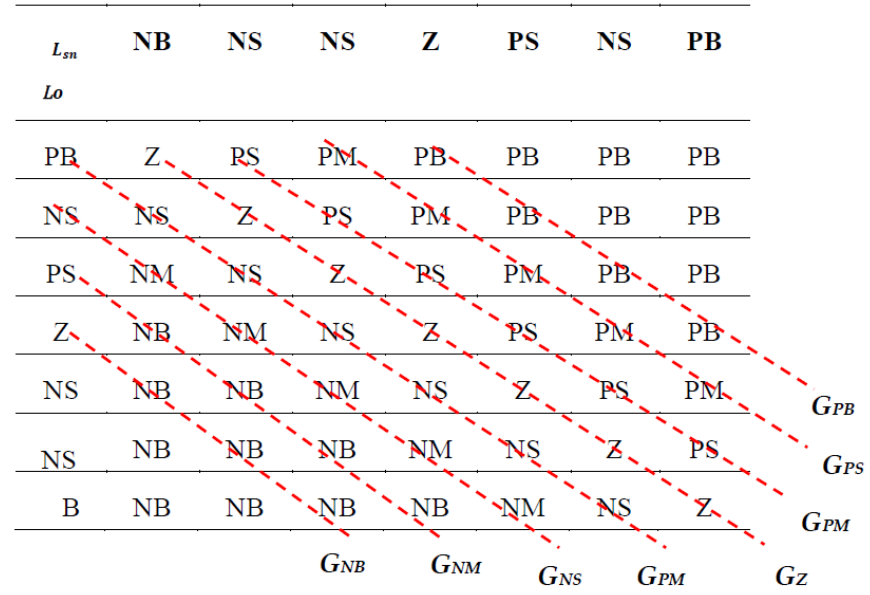
Figure 7. Using diagonals to derive the signed variable G. Table 3. New table of rules based on single dimension.